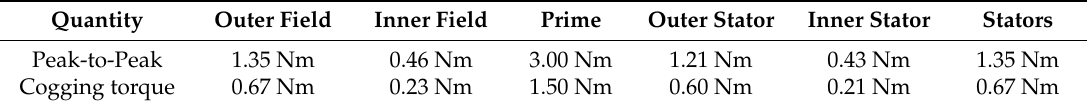
Table 5. Transmission torque characteristics of the magnetic gear.